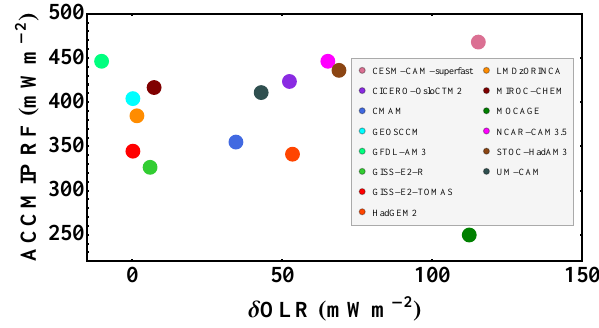
Fig. 6. ACCMIP ozone radiative forcing from preindustrial to present day as a function of δ OLR m , which is the difference be- tween ACCMIP model ozone and TES ozone weighted by the TES Instantaneous Radiative Kernel. The δ OLR is integrated through the TES diagnosed chemical tropopause q = 150ppb and averaged from